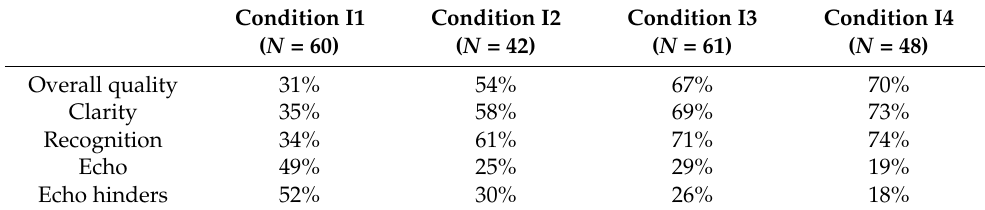
Table 4. The average results of test parameters for instruction